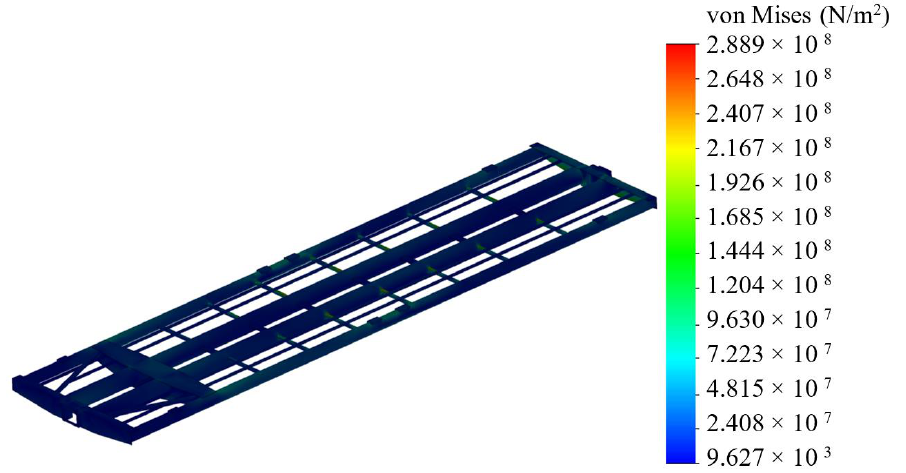
Figure 8. The stress state of the carrying structure of the flat wagon section.